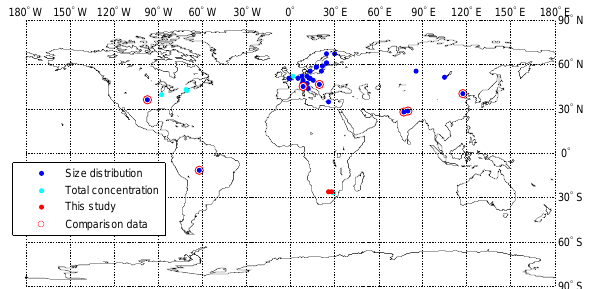
Fig. 1. Long-term observations of aerosol particle number size dis- tribution or total concentration extending below 100nm in the con- tinental boundary layer excluding urban environments. The obser- vations from the locations indicated with red circles are compared with the results of this study. Note that the South American com- parison site had only two months of